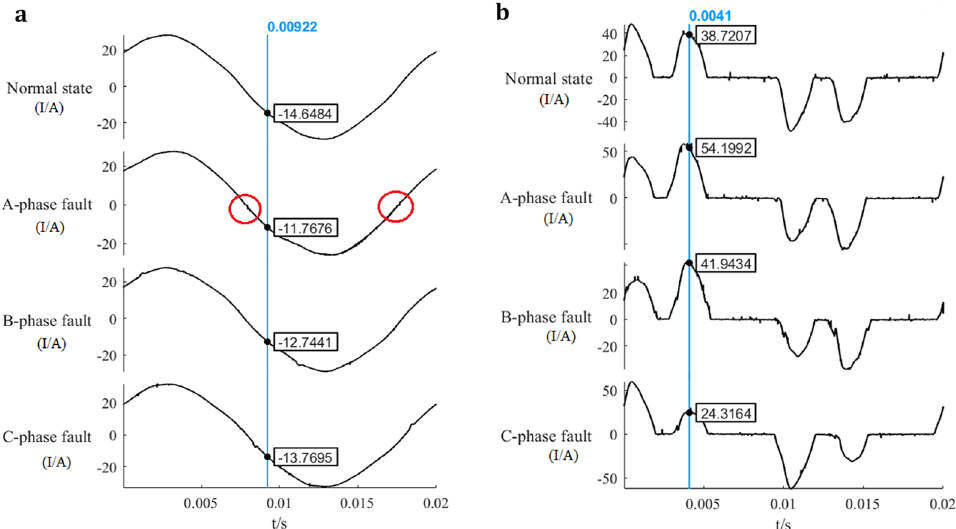
Figure 3. A-phase current waveform of three-phase motor circuit and frequency converter circuit. ( a ) A-phase current waveform of three-phase motor circuit. ( b ) A-phase current waveform of frequency converter